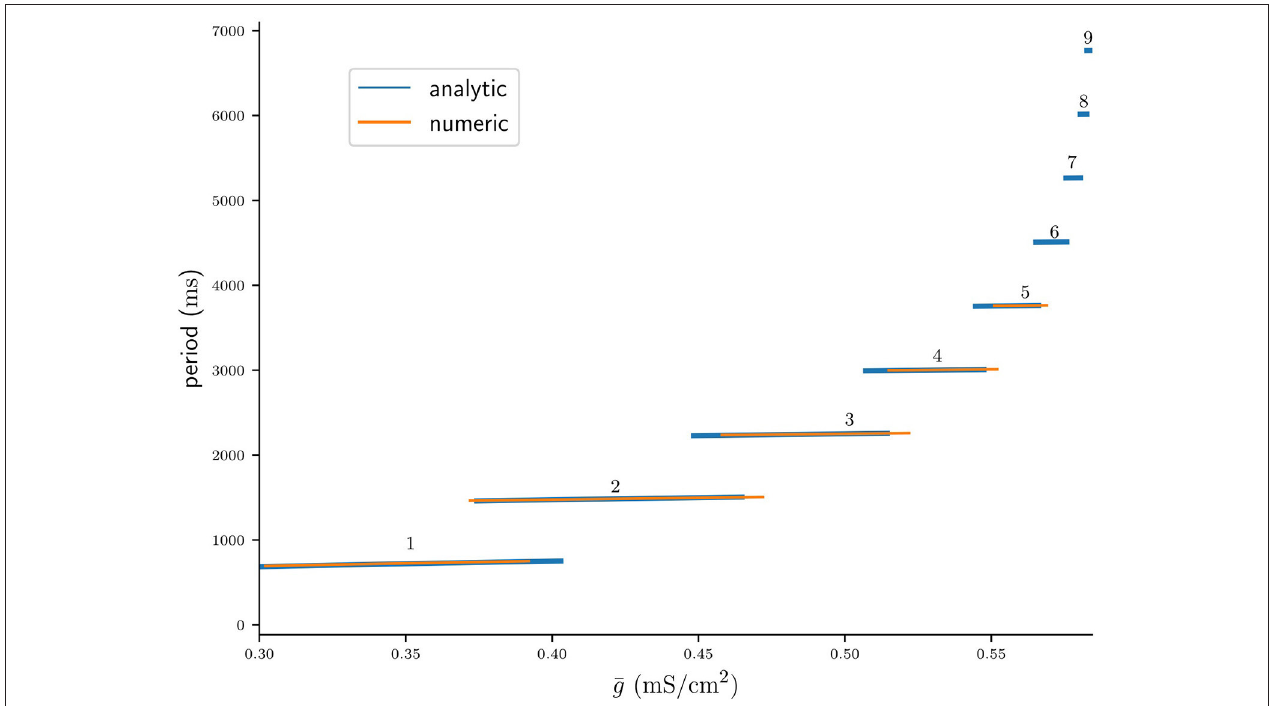
FIGURE 10 | Bifurcation diagram of the period of stable n : n solutions computed analytically from fixed points of 5 n , plotted on the respective intervals of ¯ g ∈ [ ¯ g L ( n ), ¯ g R ( n ) ] (blue), and computed from numerical integrations of the ODEs (orange).